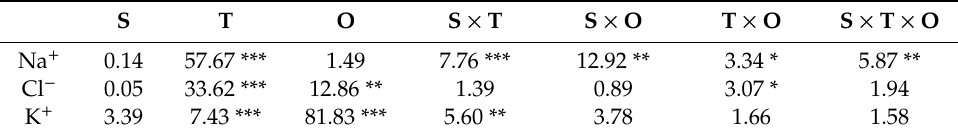
Table 4. Factorial ANOVA considering the e ff ect of species (S), treatment (T), organ (O), and their interactions (S × T; S × O; T × O; S × T × O) on ions (Na + , Cl − , K + ) contents, in Solanum melongena and S. torvum .